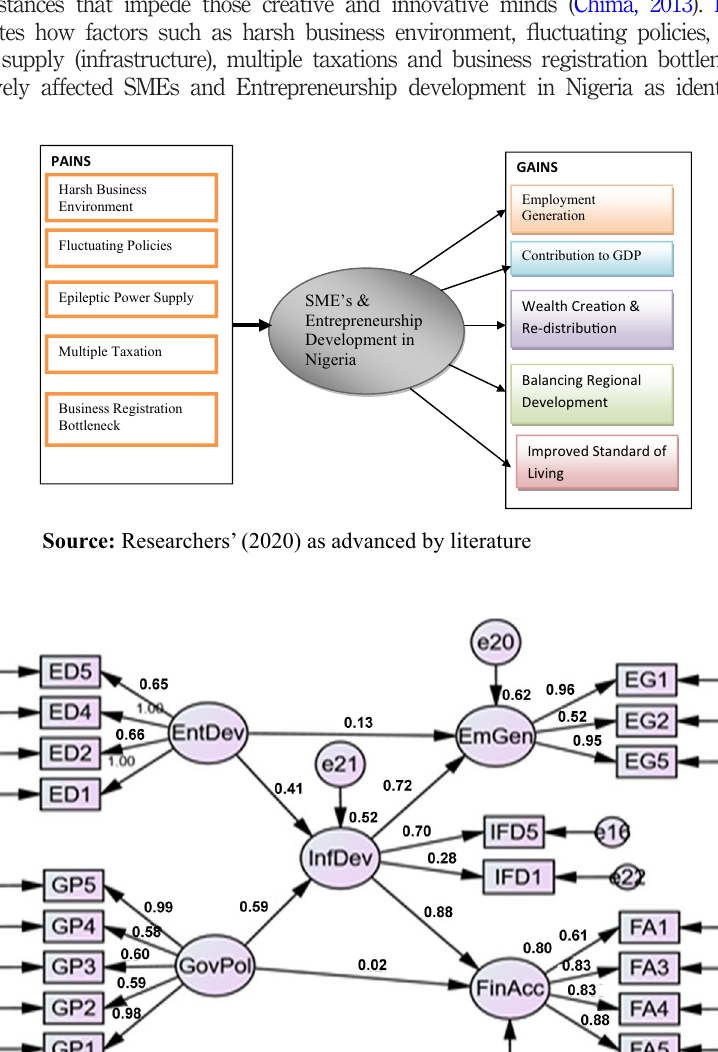
Figure 2. Model of signi fi cant direct and indirect relationship between the Pain and Gain of SMEs in